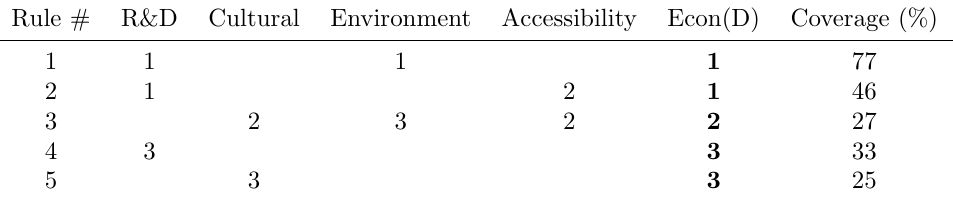
Table 3: Rough set rules explaining XXQ Economy by composite factors using 3 classes Rule # R&D